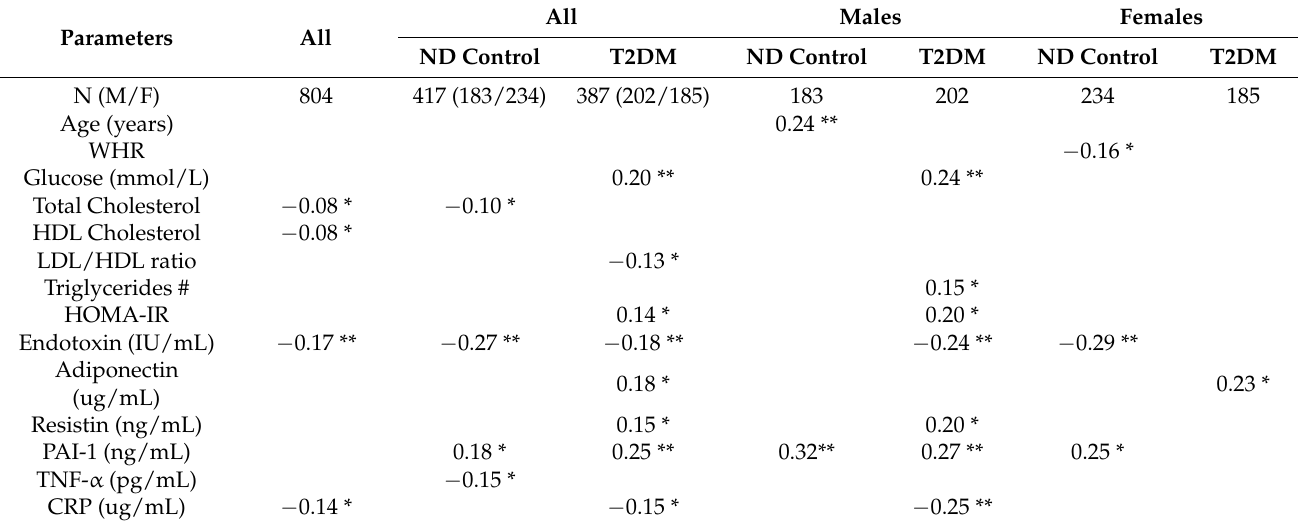
Table 4. Significant associations of TL with measured parameters.